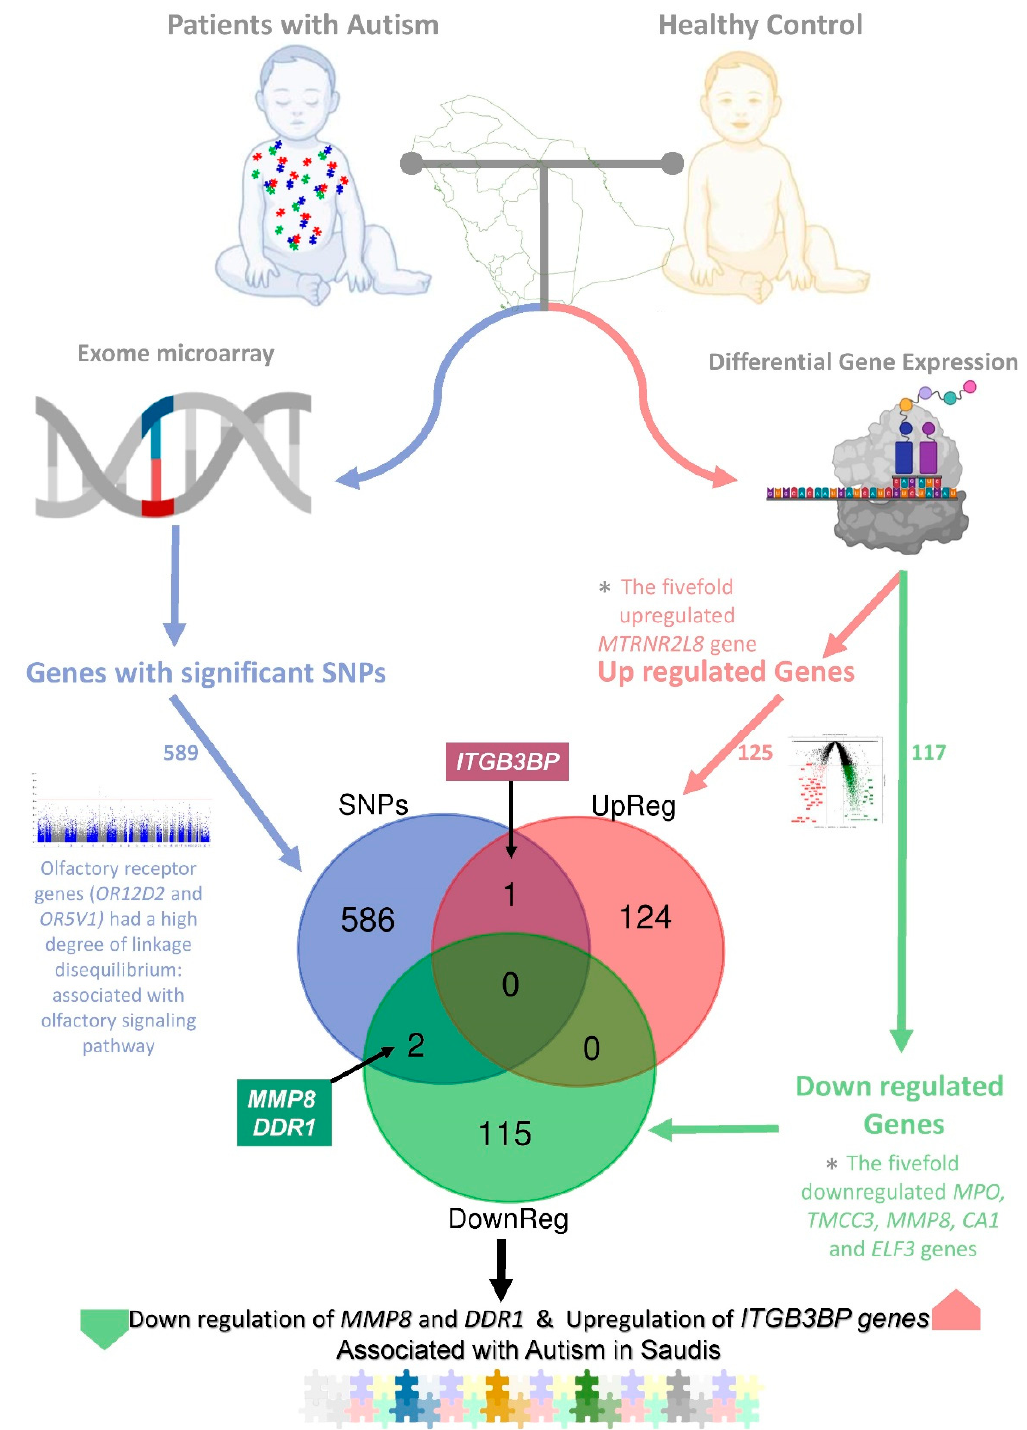
Figure 1. Integration of whole RNA sequencing-based differentially expressed gene analysis (up-regulated: foldchange ≥ 0.8 and p -value ≤ 0.05, n = 125; downregulated: foldchange ≤− 0.8 and p -value ≤ 0.05, n = 117) of patients with autism in relation to the healthy controls with genes of significant genotypes. Venn diagram analysis of the curated data identifies three (rs6657480, rs3130780, and rs1940475) regulatory variants in the up- ( ITGB3BP ) and downregulated ( DDR1 and MMP8 ) genes in autistic patients. * List of the fivefold downregulated and upregulated genes can be considered for the early identification of autism patients among Saudis.